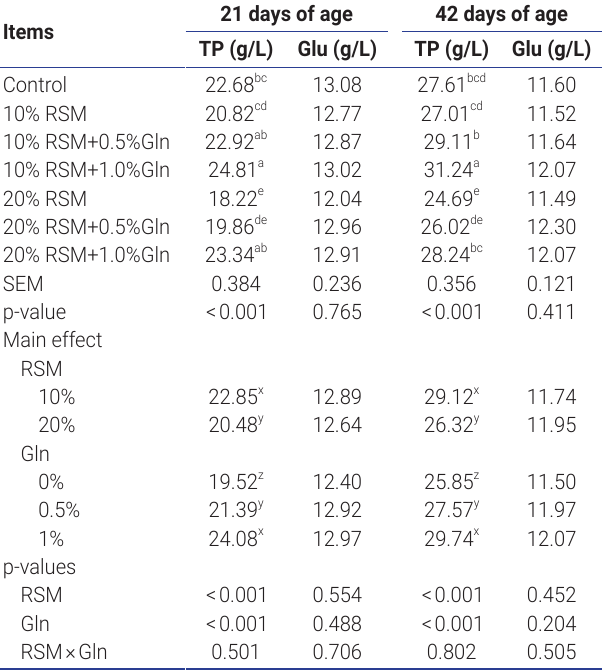
Table 4. Effects of different levels of rapeseed meal substitution and glutamine supplementation on the contents of total protein and glu- cose of Qiandongnan Xiaoxiang